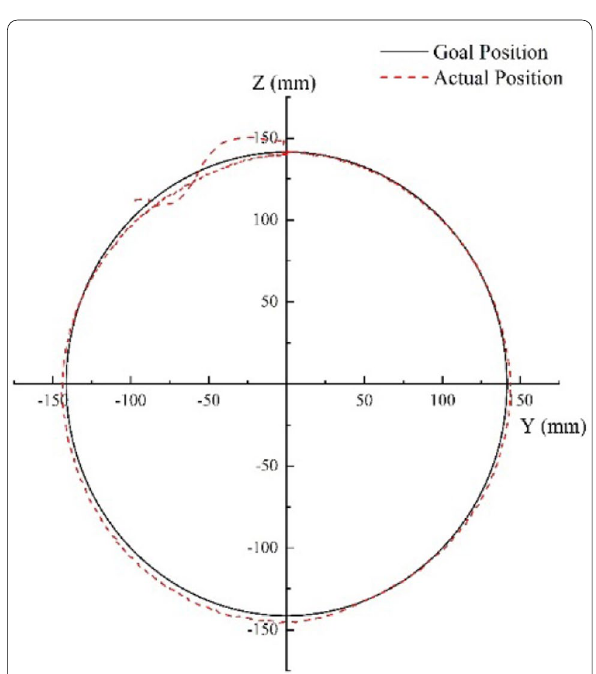
Figure 15 Tracking trajectory of the